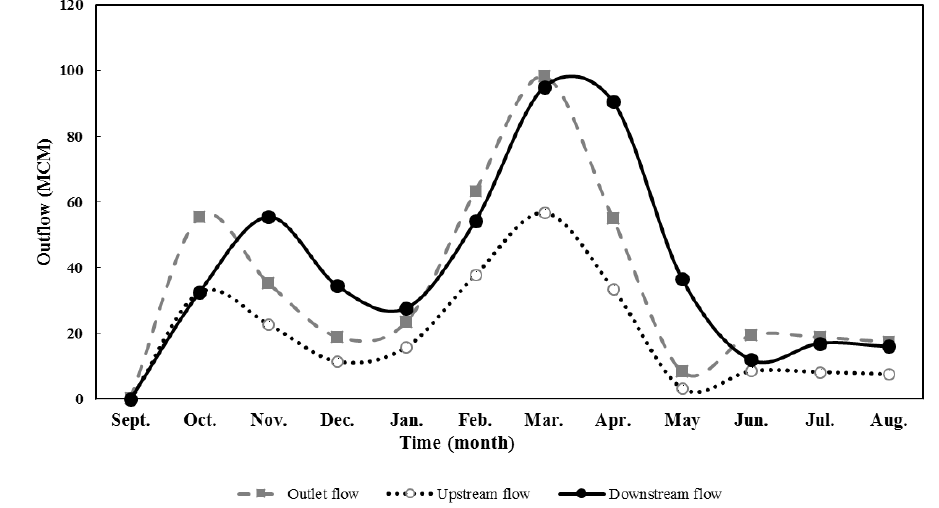
Figure 10. The results of hydrologic model for the upstream-downstream flow. In the downstream sub-watershed, the Available water stock is fed by the outflow from upstream and the runoff volume obtained from precipitation in the downstream